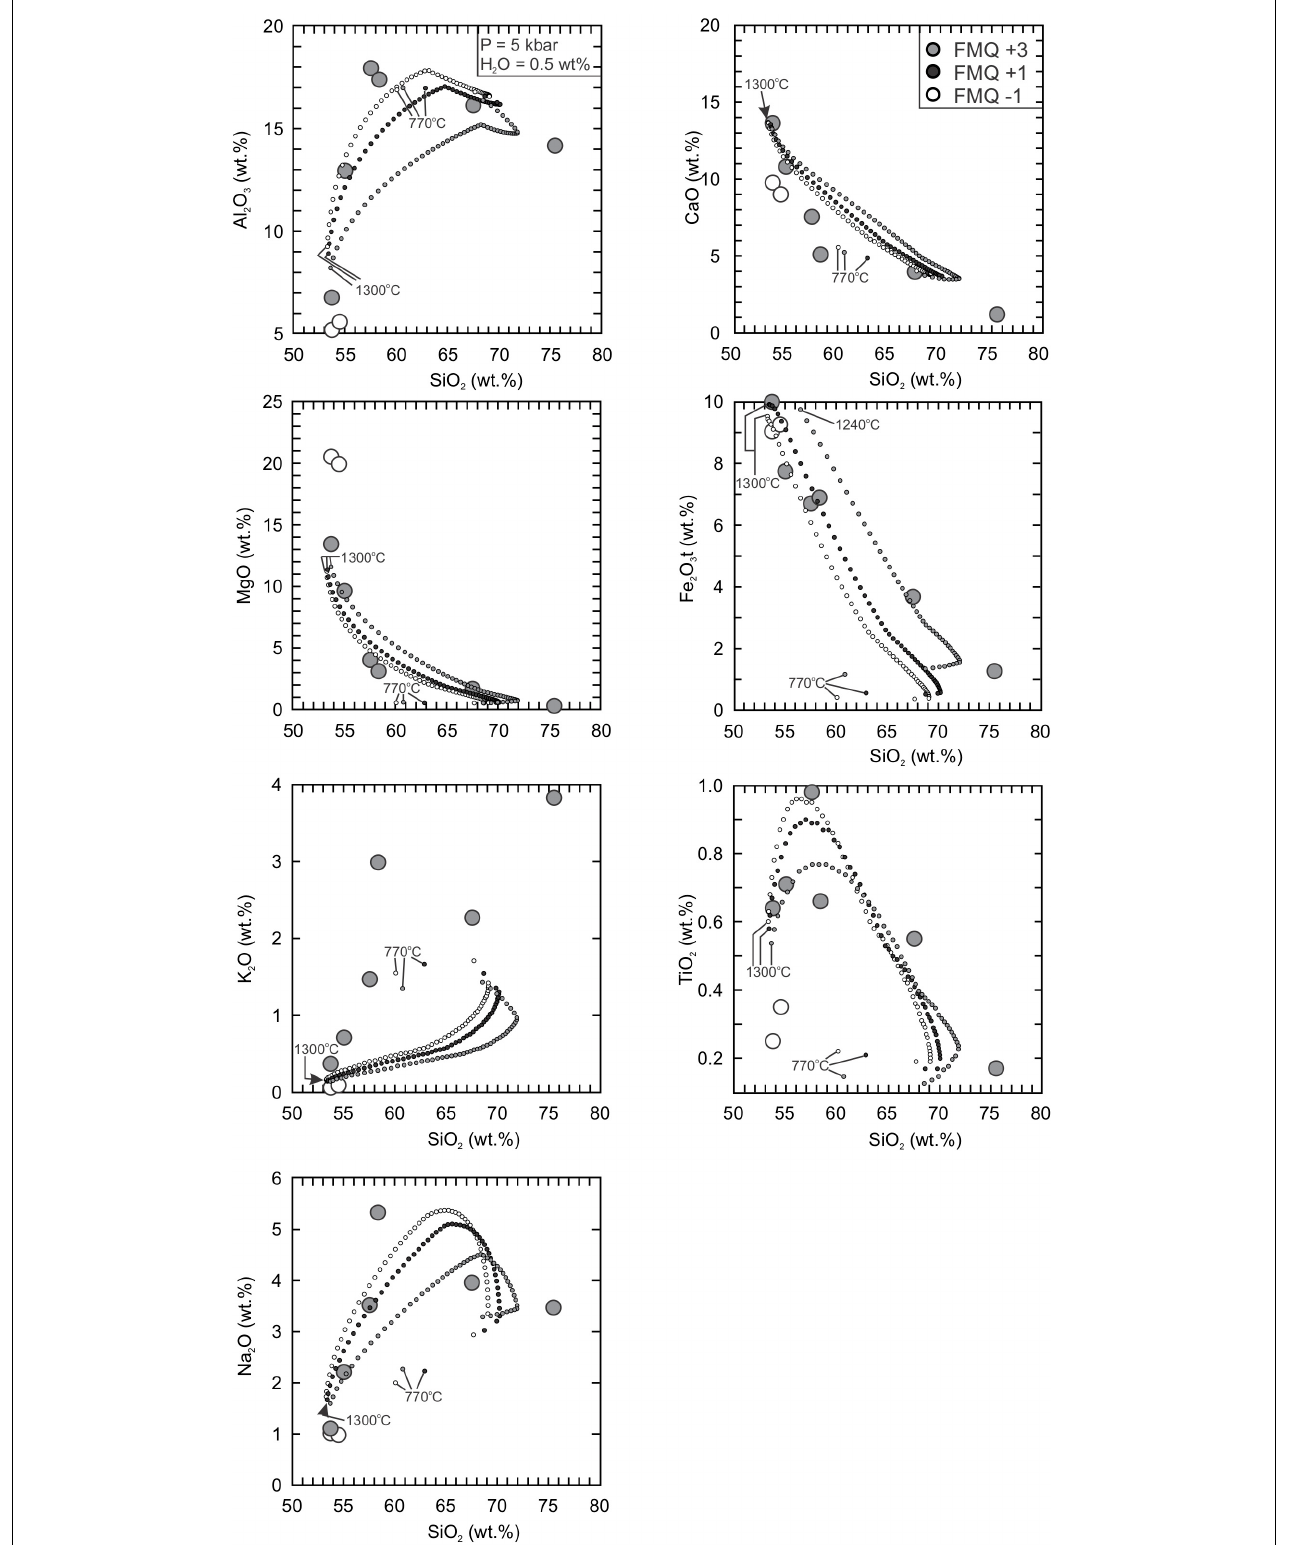
FIGURE 12 | (A–G) Results of equilibrium partial melting showing the liquid evolution paths of the Nishisonogi chlorite-actinolite schist with models represented by different colored dots (i.e., white dots = FMQ –1; black dots = FMQ + 1; gray dots = FMQ + 3). Each dot represents a 10 ◦ C interval of melting.